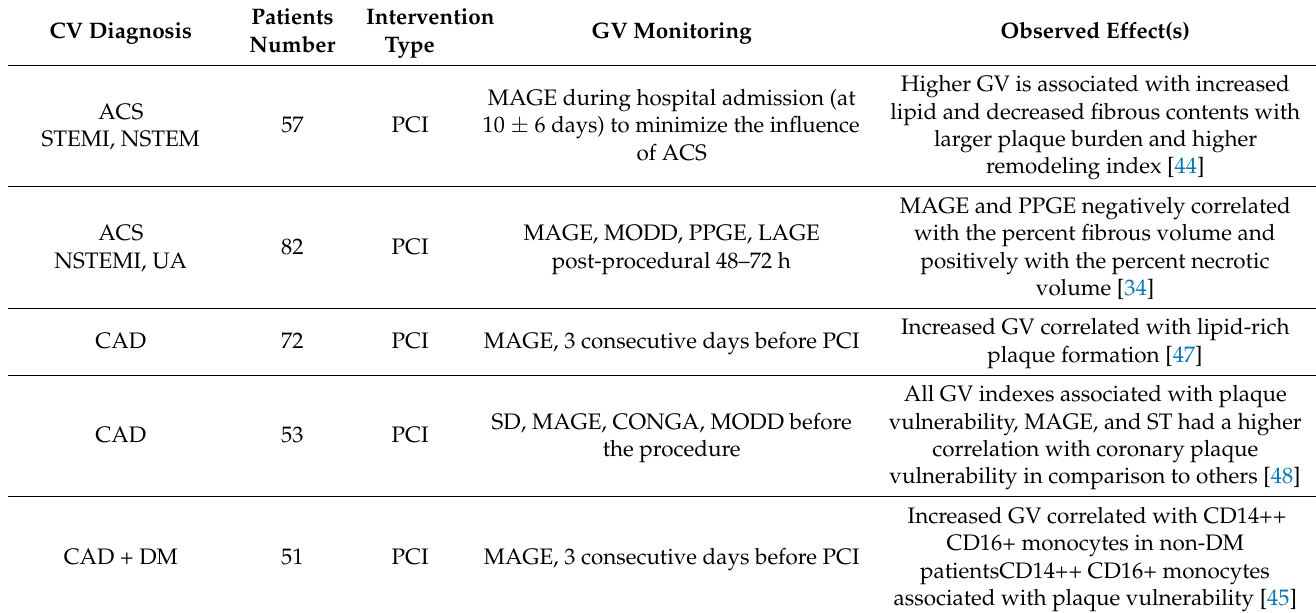
Table 3. Glucose fluctuation and plaque